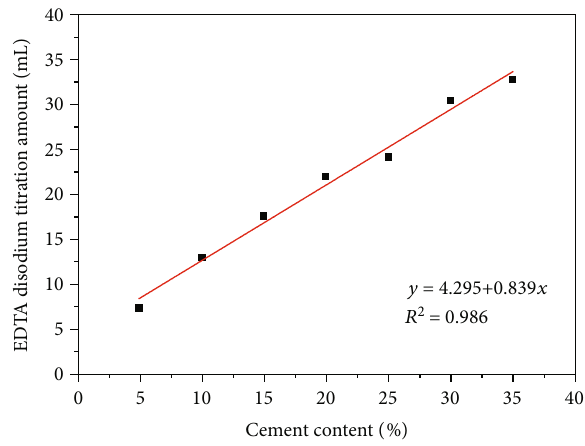
Figure 5: Correlation between disodium consumption of EDTA and cement